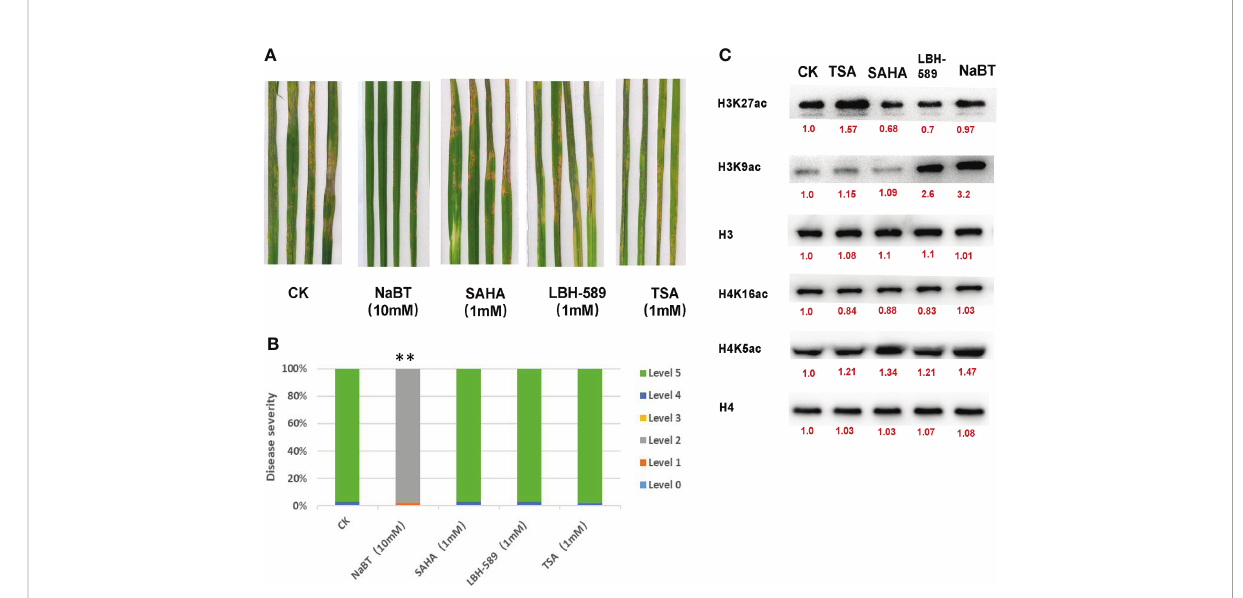
FIGURE 1 The effect of HDAC inhibitors treatment on rice blast resistance and histone acetylation in rice seedlings. (A) Leaf phenotypes after M. oryzae inoculation. Seven-day-old rice seedlings were treated with 10 mM NaBT, 1 mM SAHA, 1 mM LBH-589, 1 mM TSA. DMSO treatment serves as a control. After three weeks treatment the seedlings were inoculated with M. oryzae. Disease severity were investigated fi ve days after inoculation. (B) Estimation of the disease grade after M. oryzae inoculation in (A) (**P< 0.01). (C) Immunoblot analysis of histone acetylation in rice seedlings treated with 10mM NaBT, 1 mM SAHA,1 mM LBH-589, 1 mM TSA. ImageJ software was used to quantify the band intensities (red